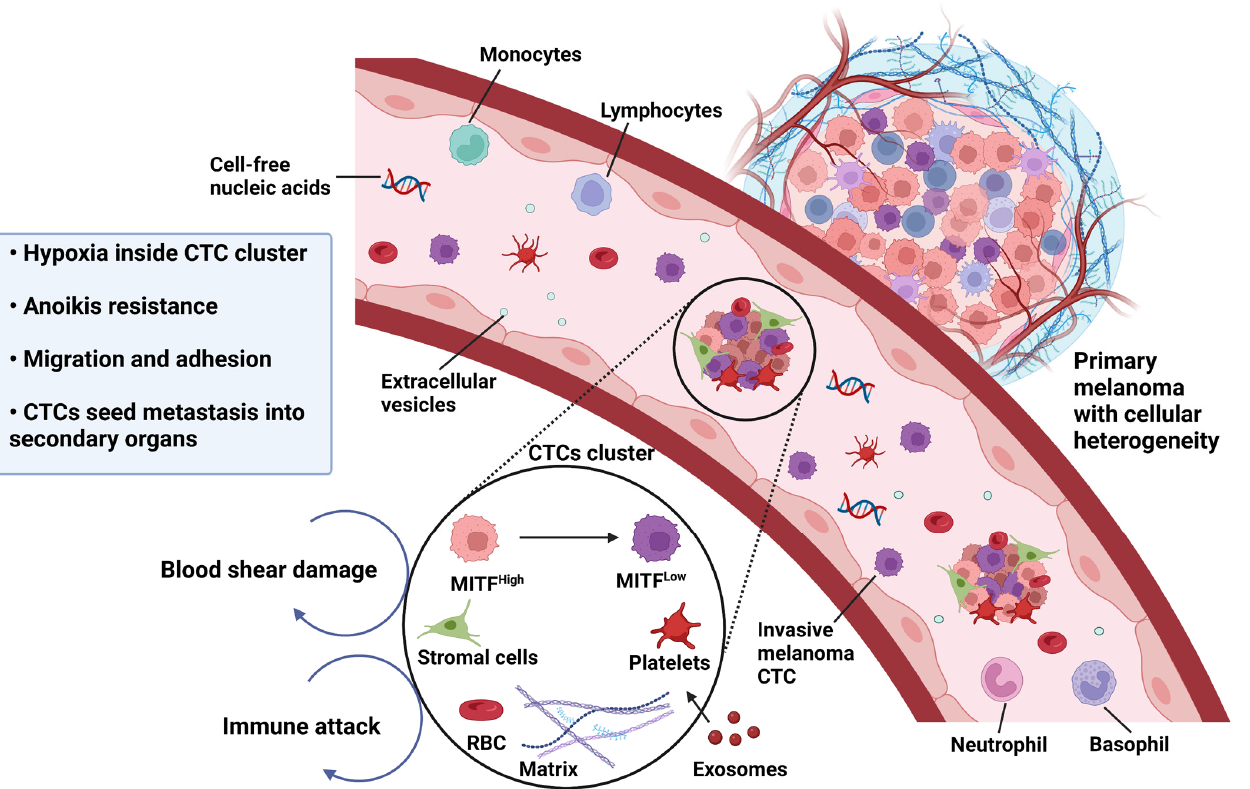
Figure 2. CTC clusters in the bloodstream are heterogeneous, and comprise cells with an MITF high proliferative phenotype, an MITF low invasive phenotype, pericytes, immune cells, platelets, and CAFs. The crosstalk between proliferative and invasive melanoma cell types in the CTC cluster facilitates seeding of CTCs and increased metastasis. Melanoma cells within the bloodstream are subject to severe stresses, such as loss of cell anchorage (anoikis), fluid shear stress, oxidative stress, and immune attack. The MITF low cells participate with MITF high cells to avoid anoikis, and the aggregation of CTCs in the bloodstream promotes avoidance of sheer forces in blood. Hypoxic conditions in the CTC clusters promotes invasion and endows circulating melanoma cells with a reactive oxygen species (ROS)-resistant phenotype that enhances CTC survival.